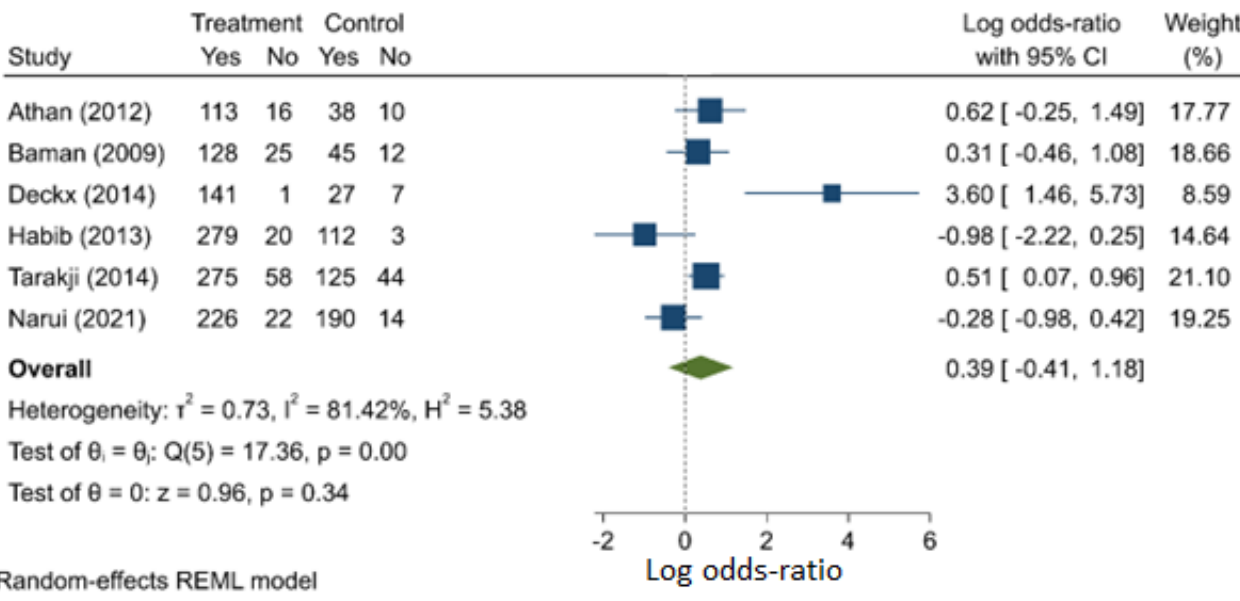
Figure 6. Presence of diabetes mellitus as risk factor for mortality.